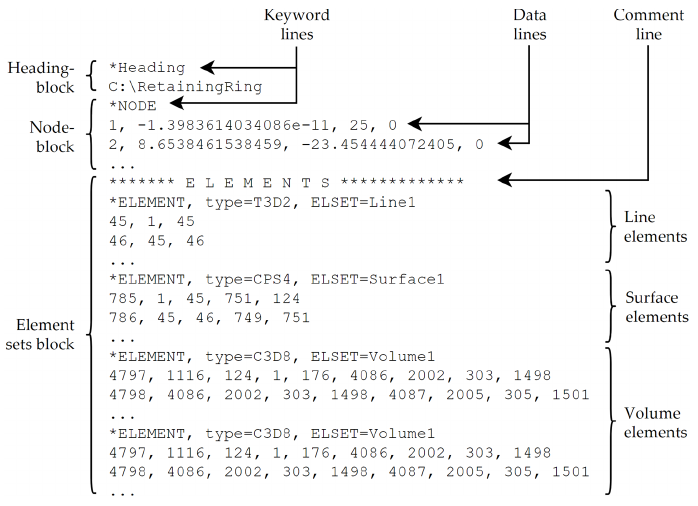
Figure 3. Basic internal structure of geometry of an Abaqus INP file.